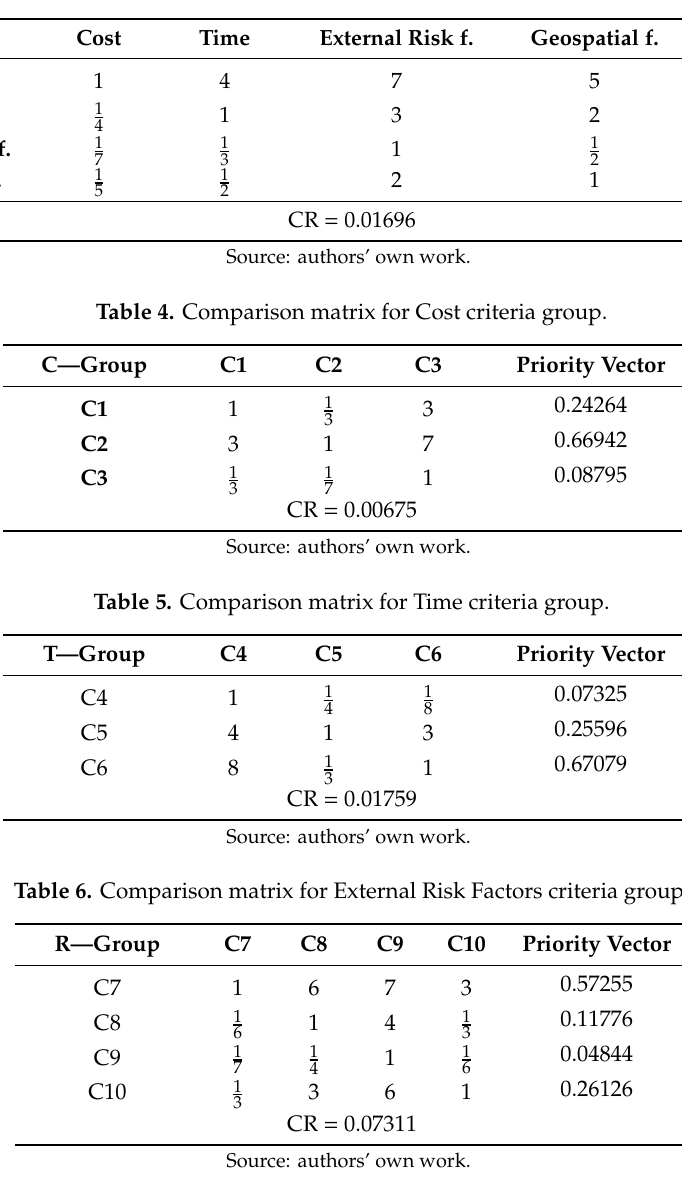
Table 3. Comparison matrix for criteria groups.